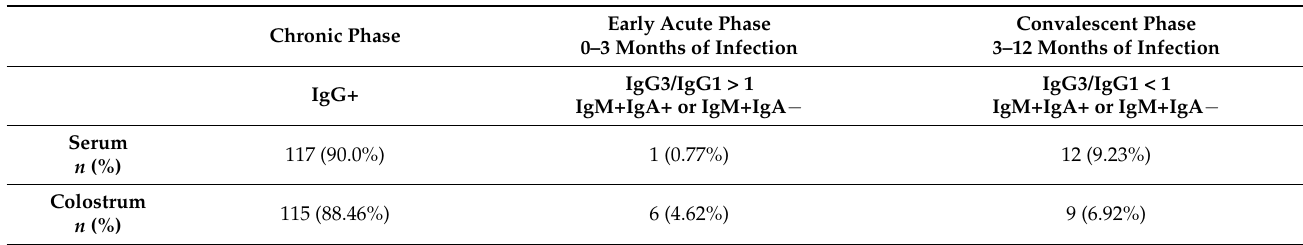
Table 2. Diagnosis status from 130 serum and colostrum samples of puerperal women from Uberl â ndia, MG.